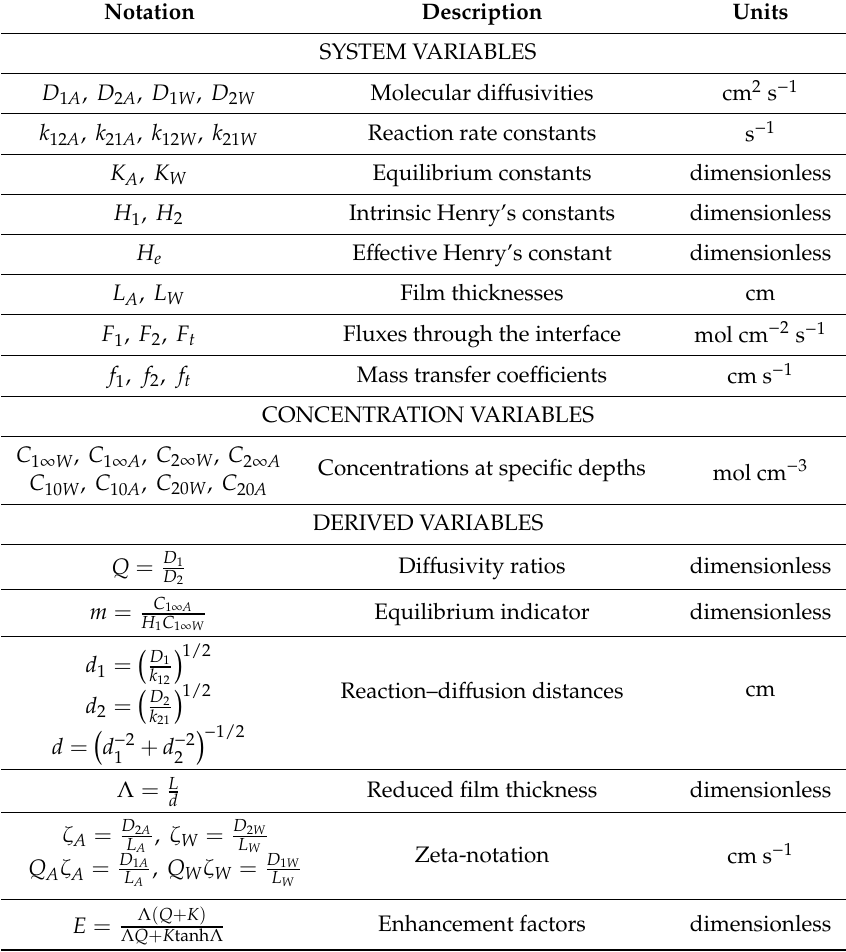
Table 1. List of system and concentration variables.